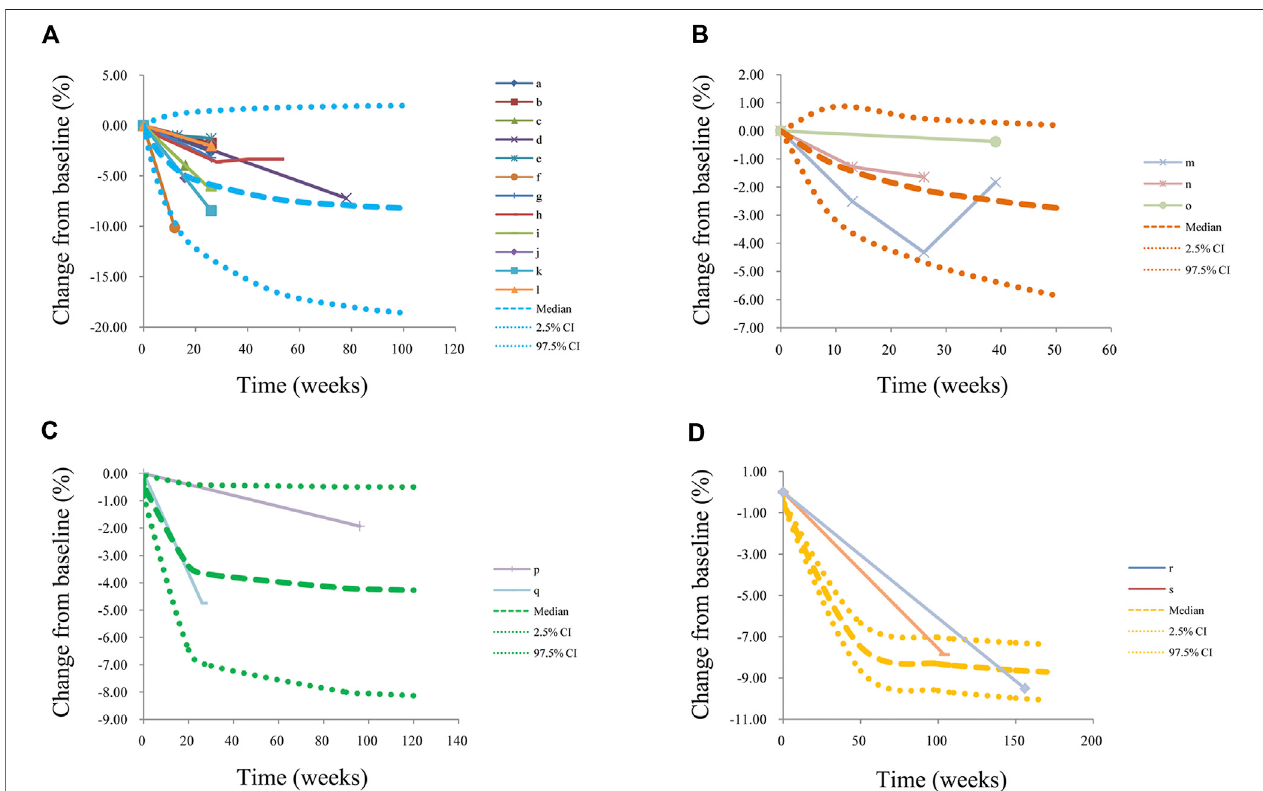
FIGURE 3 | Prediction-corrected visual predictive check plots. (A) patients with obesity, (B) patients with type 1 diabetes mellitus, (C) patients with nonalcoholic fatty liver, and (D) patients with precocity. Median, 2.5% CI, and 97.5% CI were simulated by Monte Carlo (n (cid:1) 1,000); CI; a, Pastor-Villaescusa et al. (2017); b, Pastor- Villaescusa et al. (2017); c, Garibay-Nieto et al. (2017); d, van der Aa et al. (2016); e, Kendall et al. (2013); f, Gómez-Díaz et al. (2012); g, Yanovski et al. (2011); h, Wilson et al. (2010); i, Clarson et al. (2009); j, Burgert et al. (2008); k, Atabek and Pirgon (2008); l, Love-Osborne et al. (2008); m, Nwosu et al. (2015); n, Nadeau et al. (2015); o, Codner et al. (2013); p, Lavine et al. (2011); q, Nadeau et al. (2009); r, Ibáñez et al. (2006a); s, Ibáñez et al.